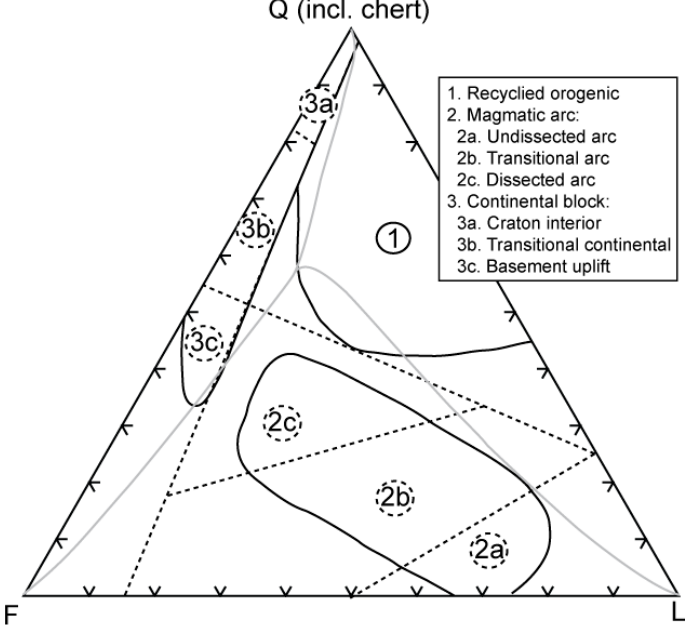
Figure 1. One of the most commonly used petrographic provenance-discriminative schemes, including the original diagram of Dickinson and Suczek [1] (solid black lines), and the modified versions of Dickinson et al. [2] (dashed black lines) and Weltje [3] (grey lines). For the use of the discrimination fields, the Gazzi–Dickinson point-counting method should be used with a grain-matrix limit of 63 µm. Only aphanitic lithic fragments are included in the lithic-fragment pool; carbonate clasts are excluded. Q: quartz (both monocrystalline and polycrystalline grains); F: feldspar; L: lithic fragments (excluding carbonate and other mono--mineralic polycrystalline grains). “Chert” encompasses both sedimentary and volcanic microcrystalline quartz.